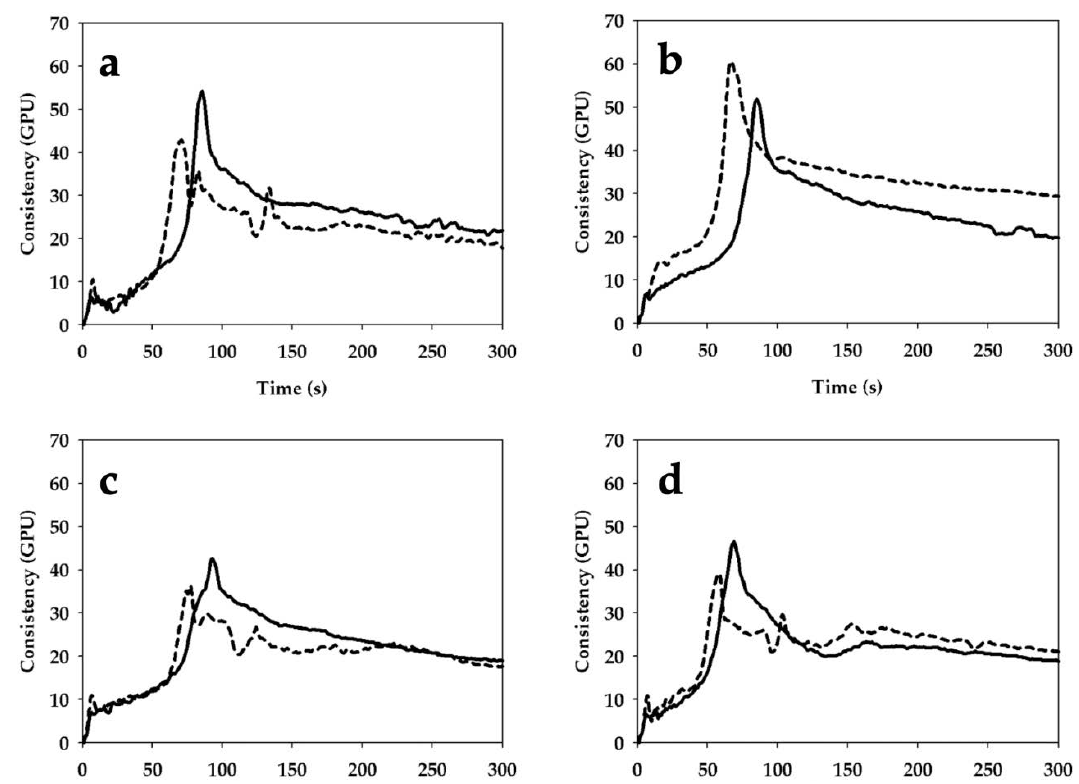
Figure 2. Effect of stone milling (solid line) and roller milling (dash line) on gluten aggregation properties, assessed by GlutoPeak ® , of whole grain flours from Bolero cv ( a ), CWRS ( b ), Bona Vita cv ( c ) and Skorpion cv ( d ). CWRS: commercial Canada Western Red Spring Wheat; GPU: GlutoPeak Units.